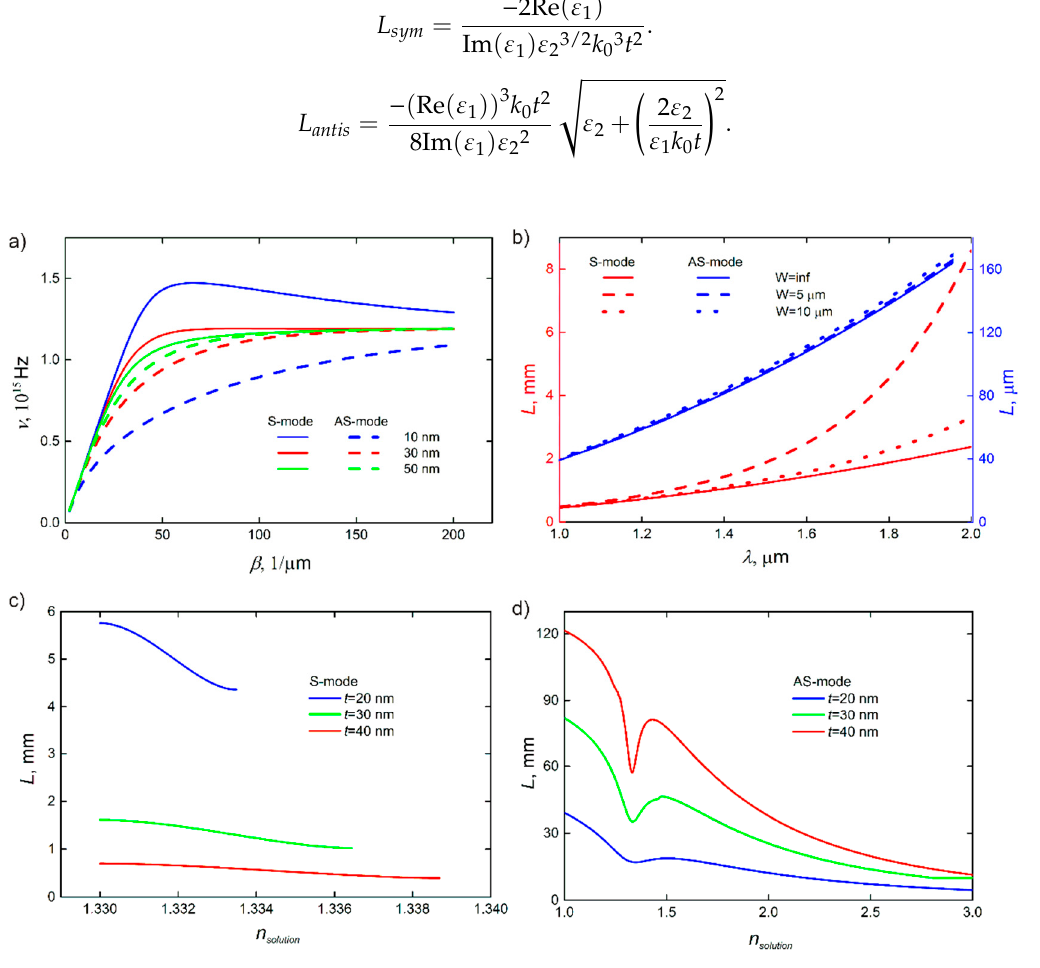
Figure 3. ( a ) Dispersion curves and propagation length in plasmonic strip waveguides. Relationship between frequency and propagation constant for two modes propagated in the thin metal film for different thickness of the film. ( b ) Dependence of propagation length for basic modes in strip waveguides on a wavelength with different waveguide width. ( c , d ) Propagation length depending on the RI of a test solution for different thicknesses of the waveguide for symmetric (S)- and antisymmetric (AS)-modes, respectively. The RI of the dielectric substrate in this scheme is 1.33.